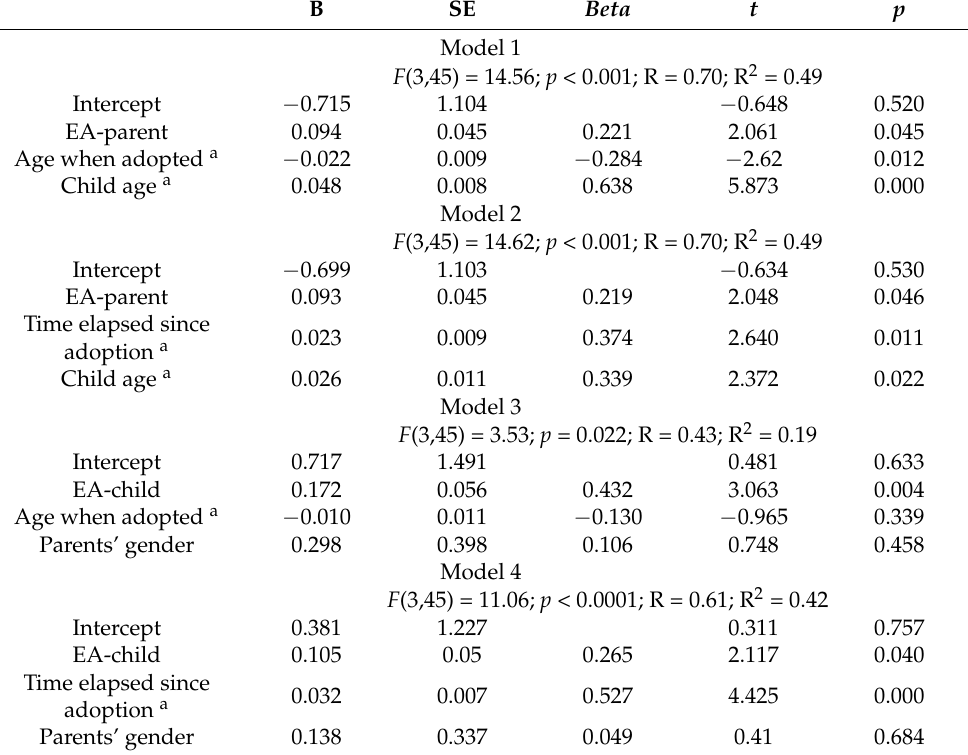
Table 4. Regression